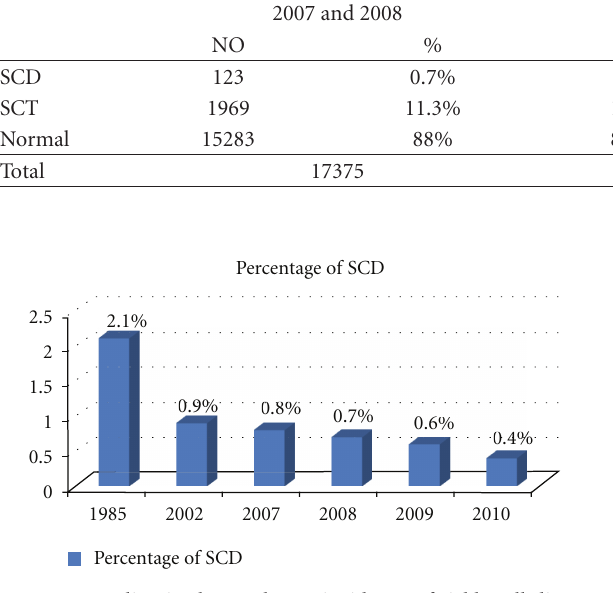
Figure 1: Decline in the newborns incidence of sickle cell disease between 1985 and